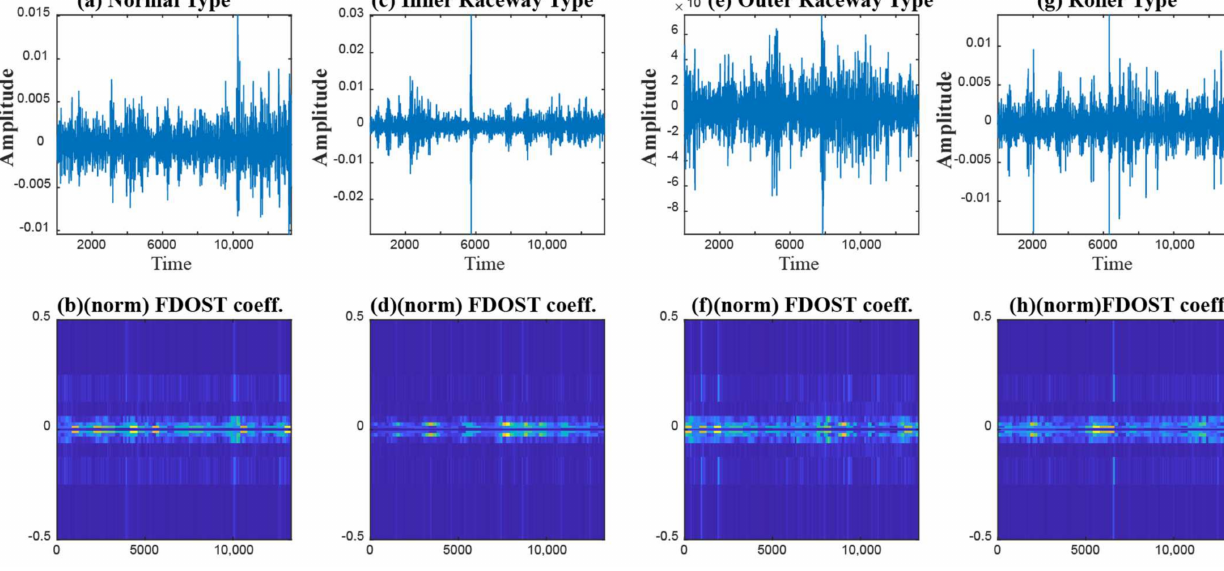
Figure 18. The visualization of dataset 3 in terms of raw time domain signals and the respective 2D FDOST coefficient matrix—( a , b ): time domain, and 2D FDOST coefficient of NT, ( c , d ): time domain, and 2D FDOST coefficient of IRT, ( e , f ): time domain, and 2D FDOST coefficient of ORT, and ( g , h ): time domain, and 2D FDOST coefficient of